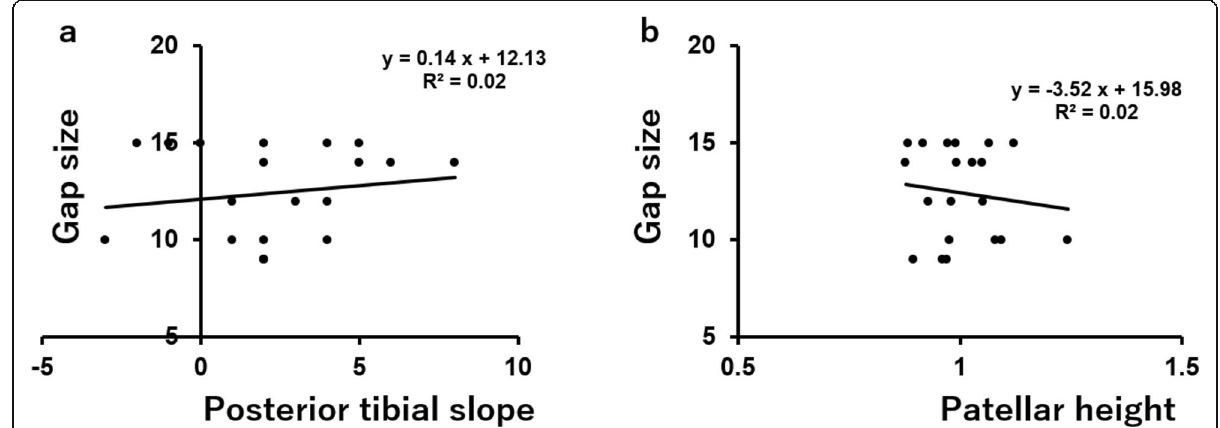
Fig. 6 The correlation between the flexion gap with the trial component posterior tibial slope ( a ) or patellar height ( b